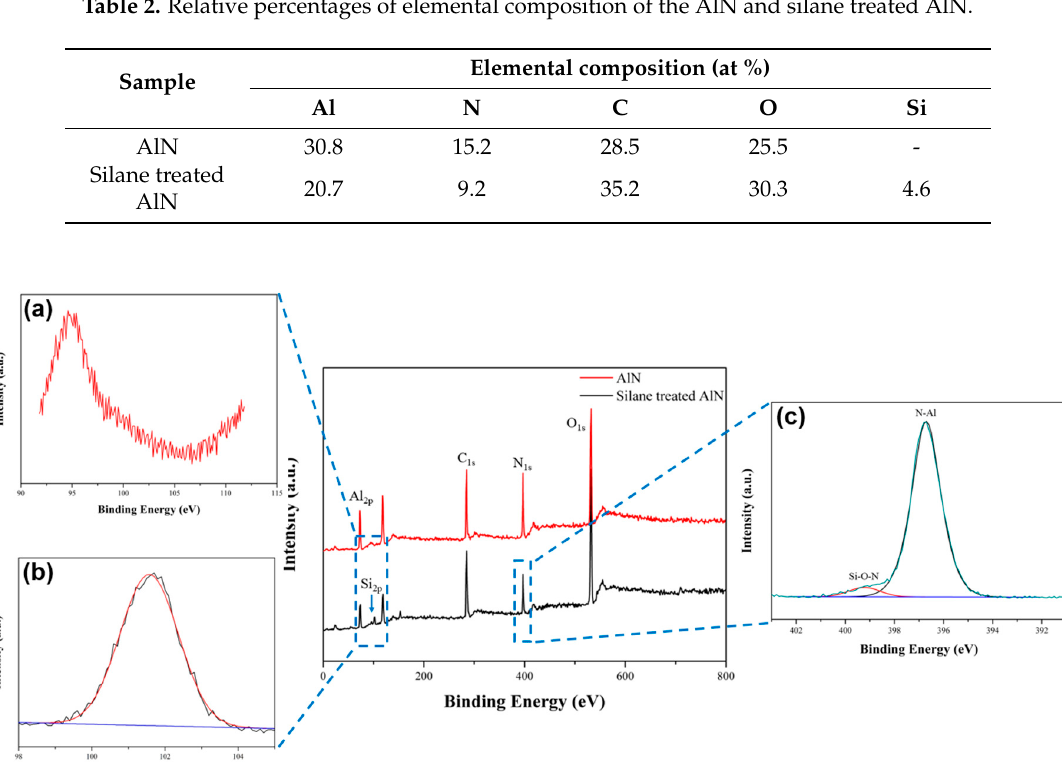
Figure 4. UV–Visible transmittances of the MWCNTs/AlN in ethanol depending on the time. The morphology of the hybrid filler system with the grafting of the AlN particles on the MWCNTs was observed by FE-SEM as shown in Figure 5. Figure 5a,b were the FE-SEM images of